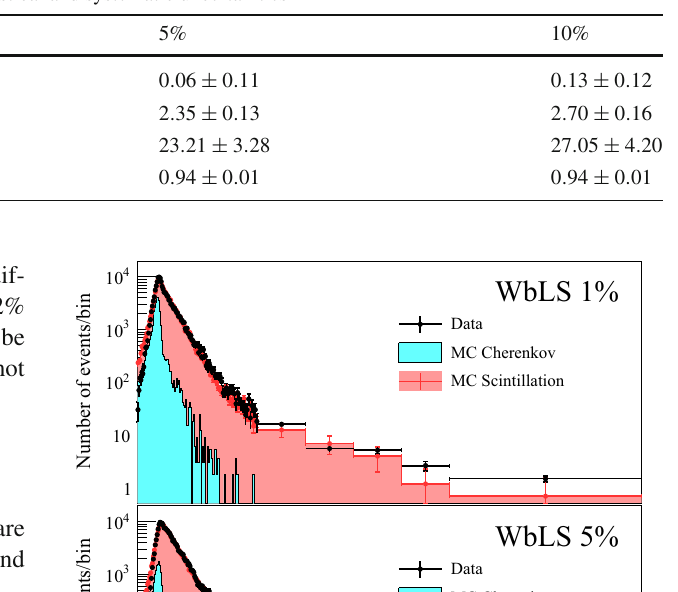
Table 2 Time profile best fit parameters. From top to bottom: rise time, short decay time, long decay time, and fraction of the short decay time component over the total. The quoted uncertainties include the statistical and systematic uncertainties